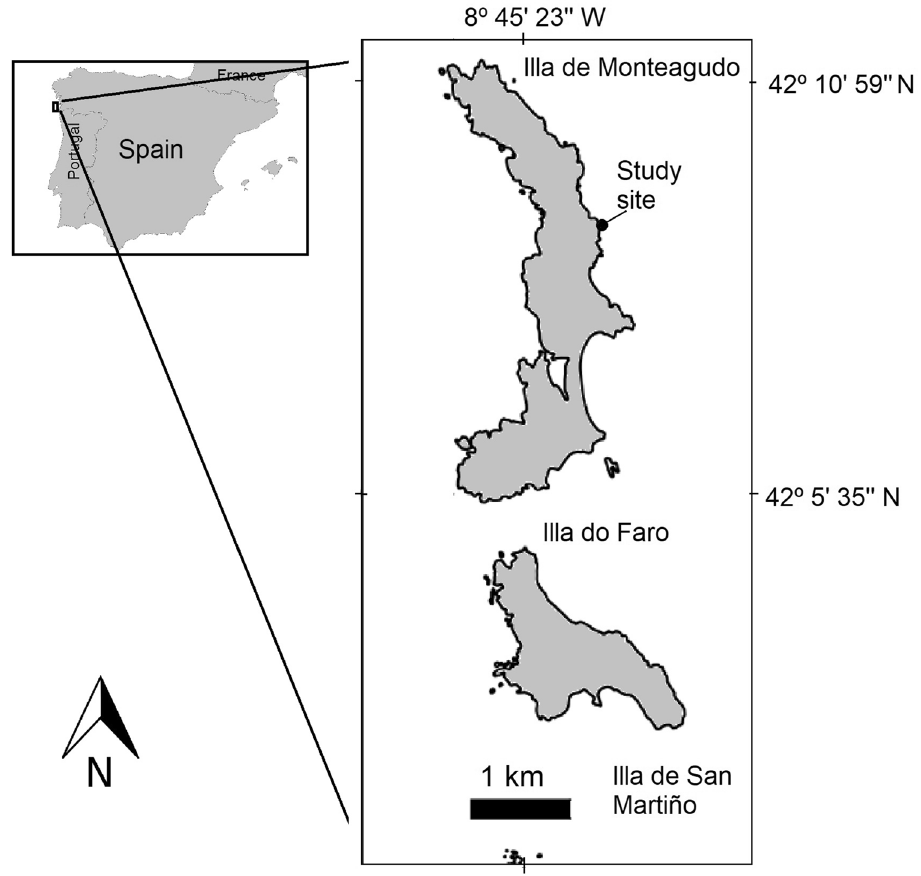
Figure 6. Location of the field measurements and the rocky intertidal sampling site on the Cíes Islands (Atlantic Islands of Galicia National Park, NW Spain). Map derived from BDLJE CC-BY 4.0 www.scne.es, modified with QGIS 3.4.5. software